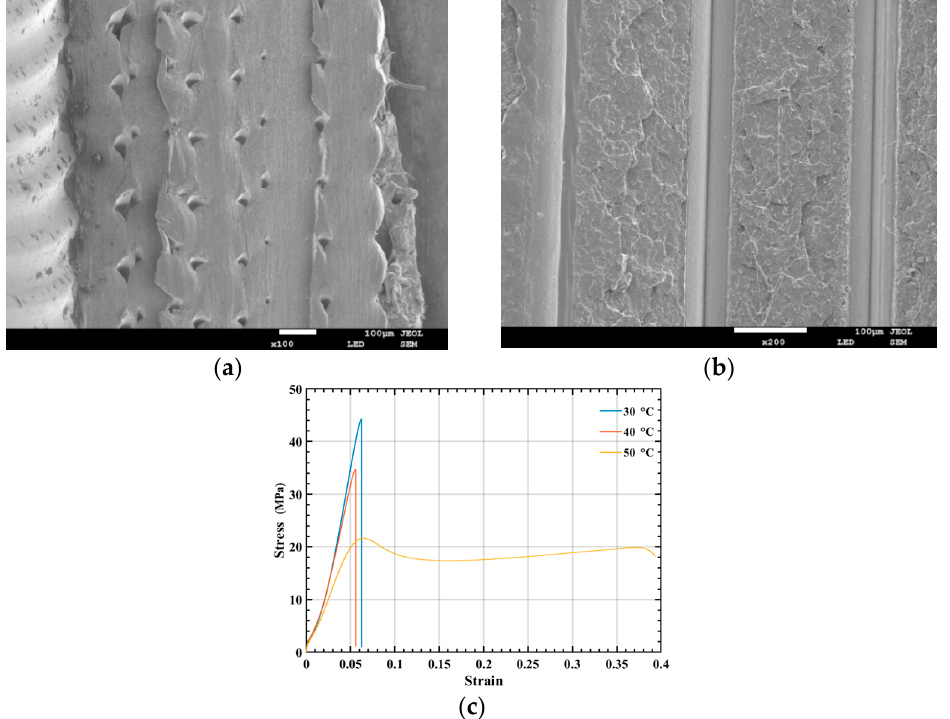
Figure 3. ( a ) The fracture surface of the sample at 0° printing direction; ( b ) the fracture surface of the sample at 90° printing direction; ( c ) the true stress-strain curve of PLA tensile sample at different temperatures.